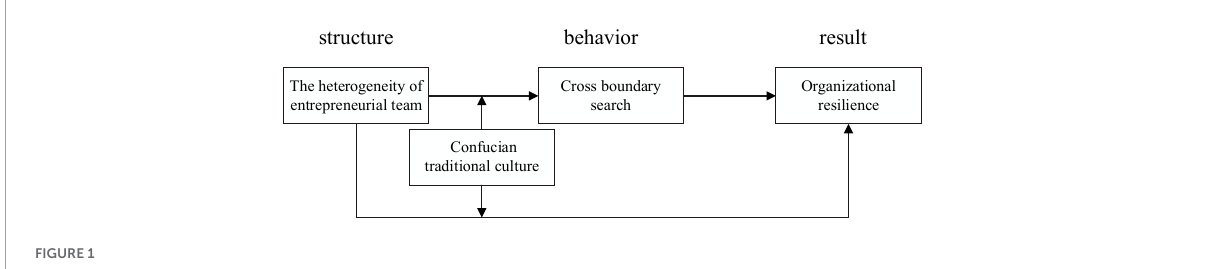
FIGURE1 “Structure-behavior-result” theoretical model.